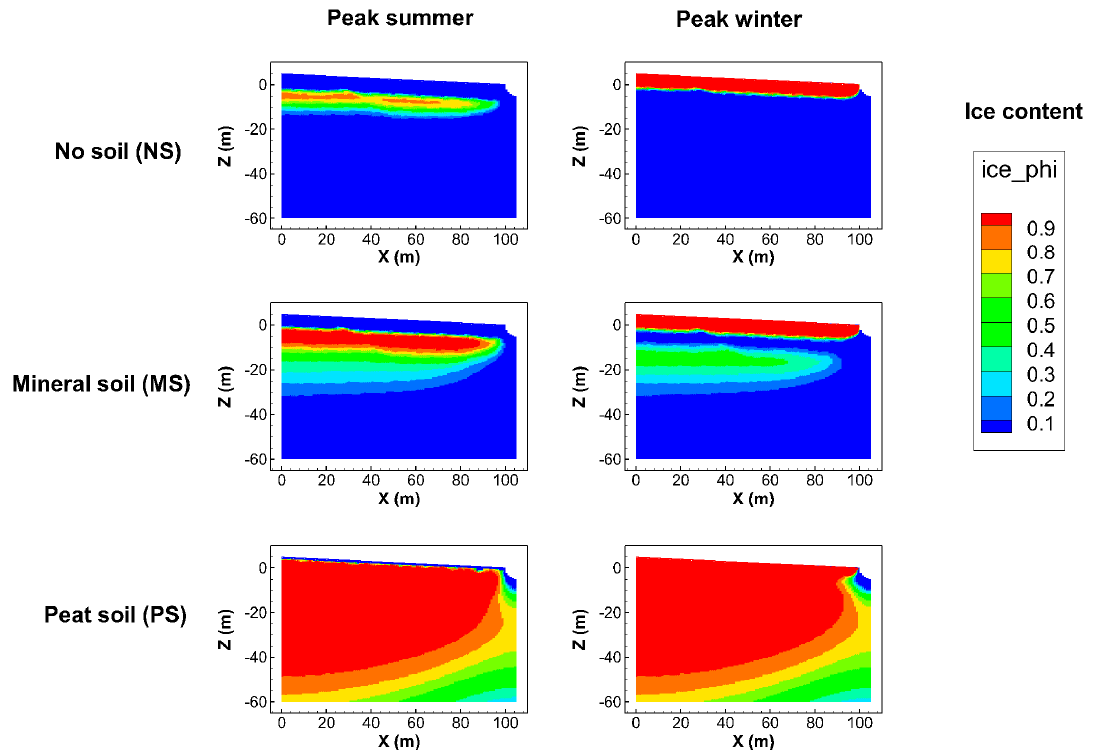
Figure 3. Resulting ice content conditions in peak summer ( left ) and peak winter ( right ) under stable average surface temperatures ( − 1 °C, no warming) for the simulation cases of no soil (NS), mineral soil (MS), and peat soil (PS).